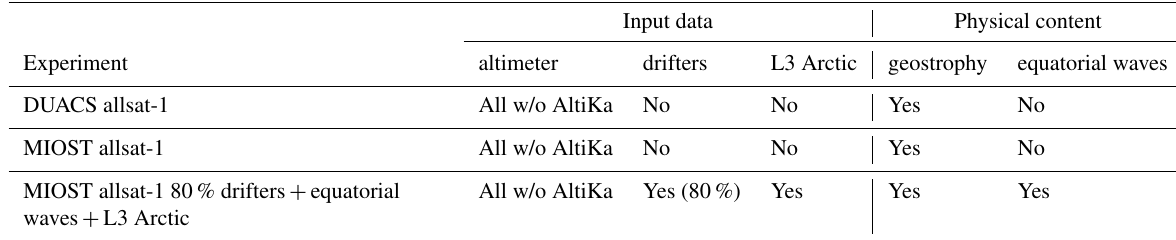
Table 3. List of mapping experiments with the input data and physical content